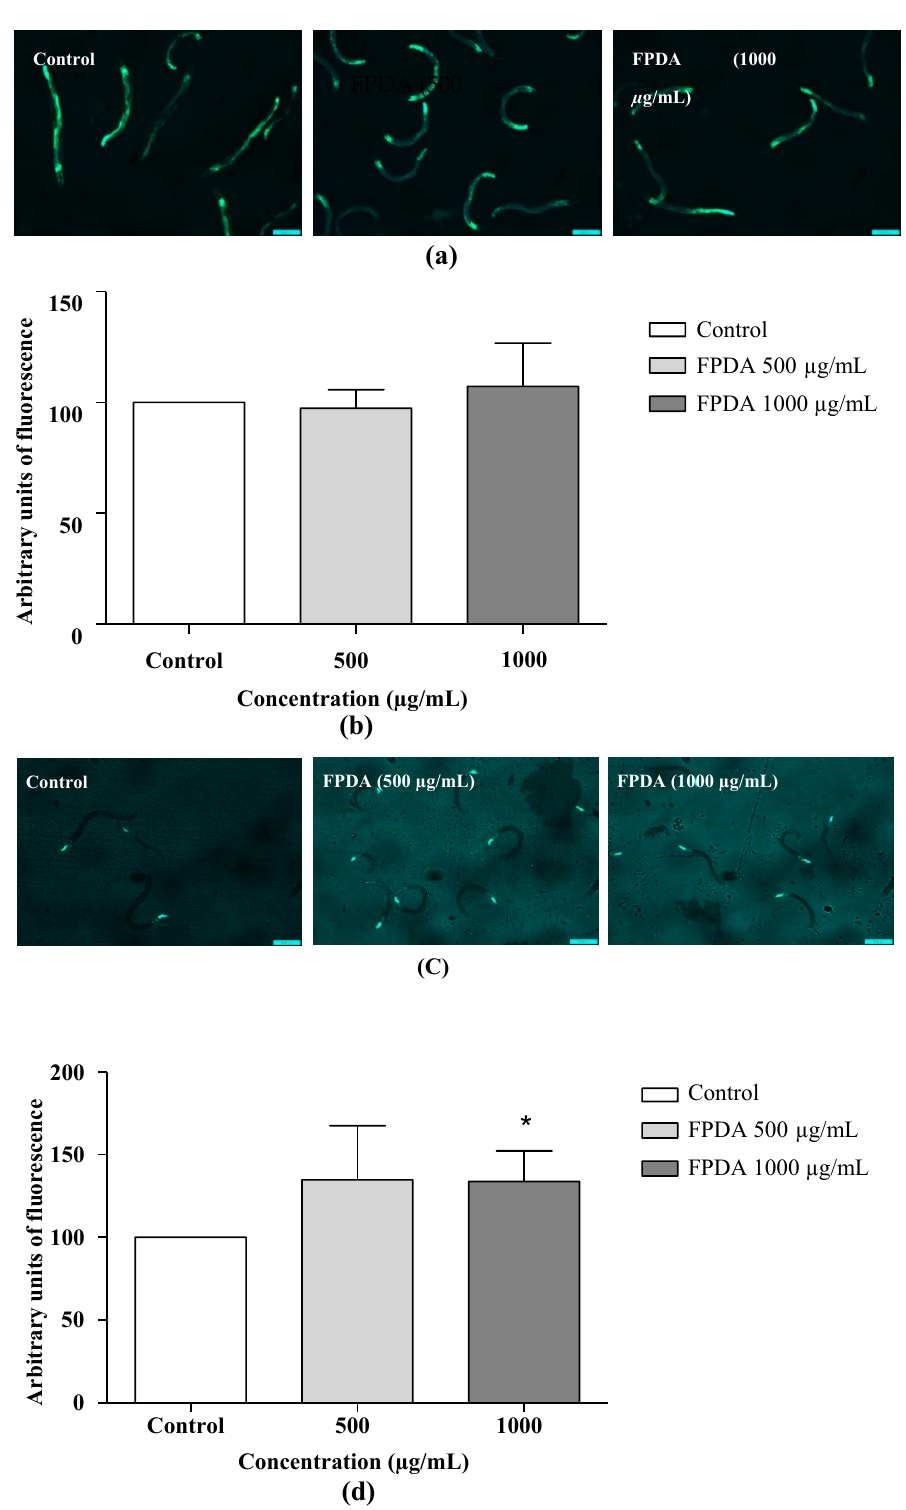
Figure 7. Glutathione transferase (GST-4) and superoxide dismutase (SOD-3) expression in the in vivo experimental model of C. elegans subjected to treatment with FPDA. ( a ) Images representative of the expression of GST-4:GFP in treated and untreated nematodes. ( b ) Quantification of GST-4:GFP in treated and untreated nematodes. ( c ) Images representative of the expression of SOD-3:GFP in treated and untreated nematodes; ( d ) Quantification of SOD-3:GFP in treated and untreated nematodes. * Statistically significant results ( p < 0.05) when the treated group was compared with the control group.